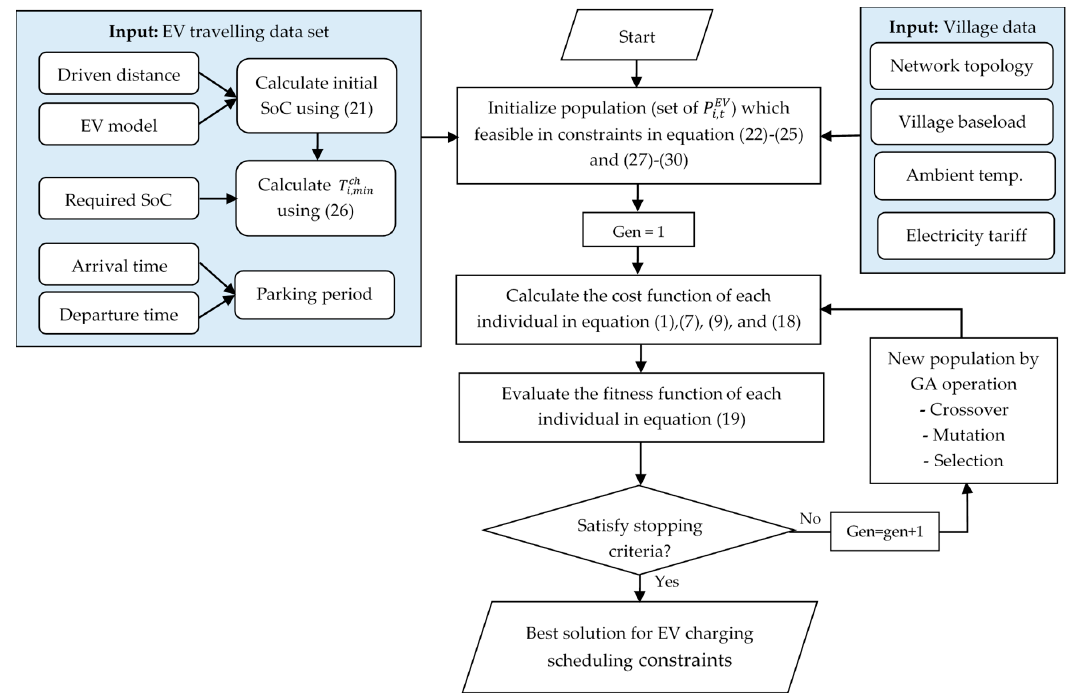
Figure 1. The proposed optimization process based on the genetic algorithm (GA) method.